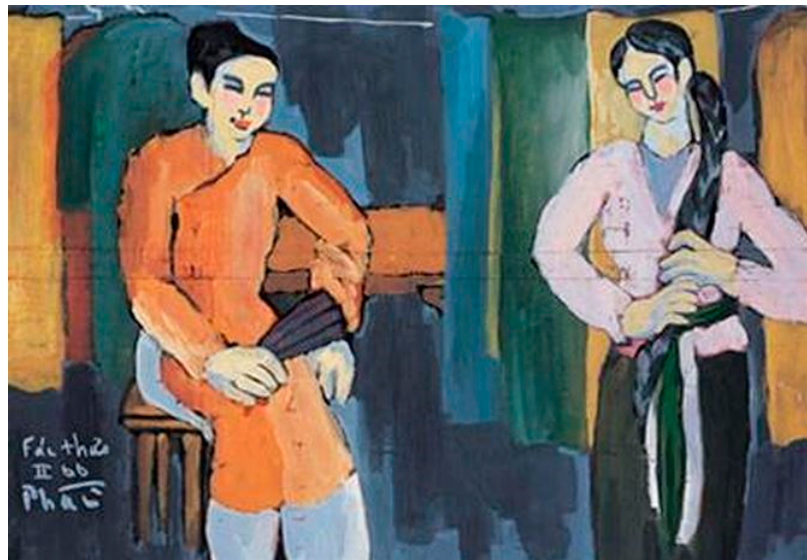
Figure A9. Fac Thao —Bui Xuan Phai. Auctioned at Sotheby’s, October 2008. The images were sourced from Tien Phong Newspaper (Luong 2008).